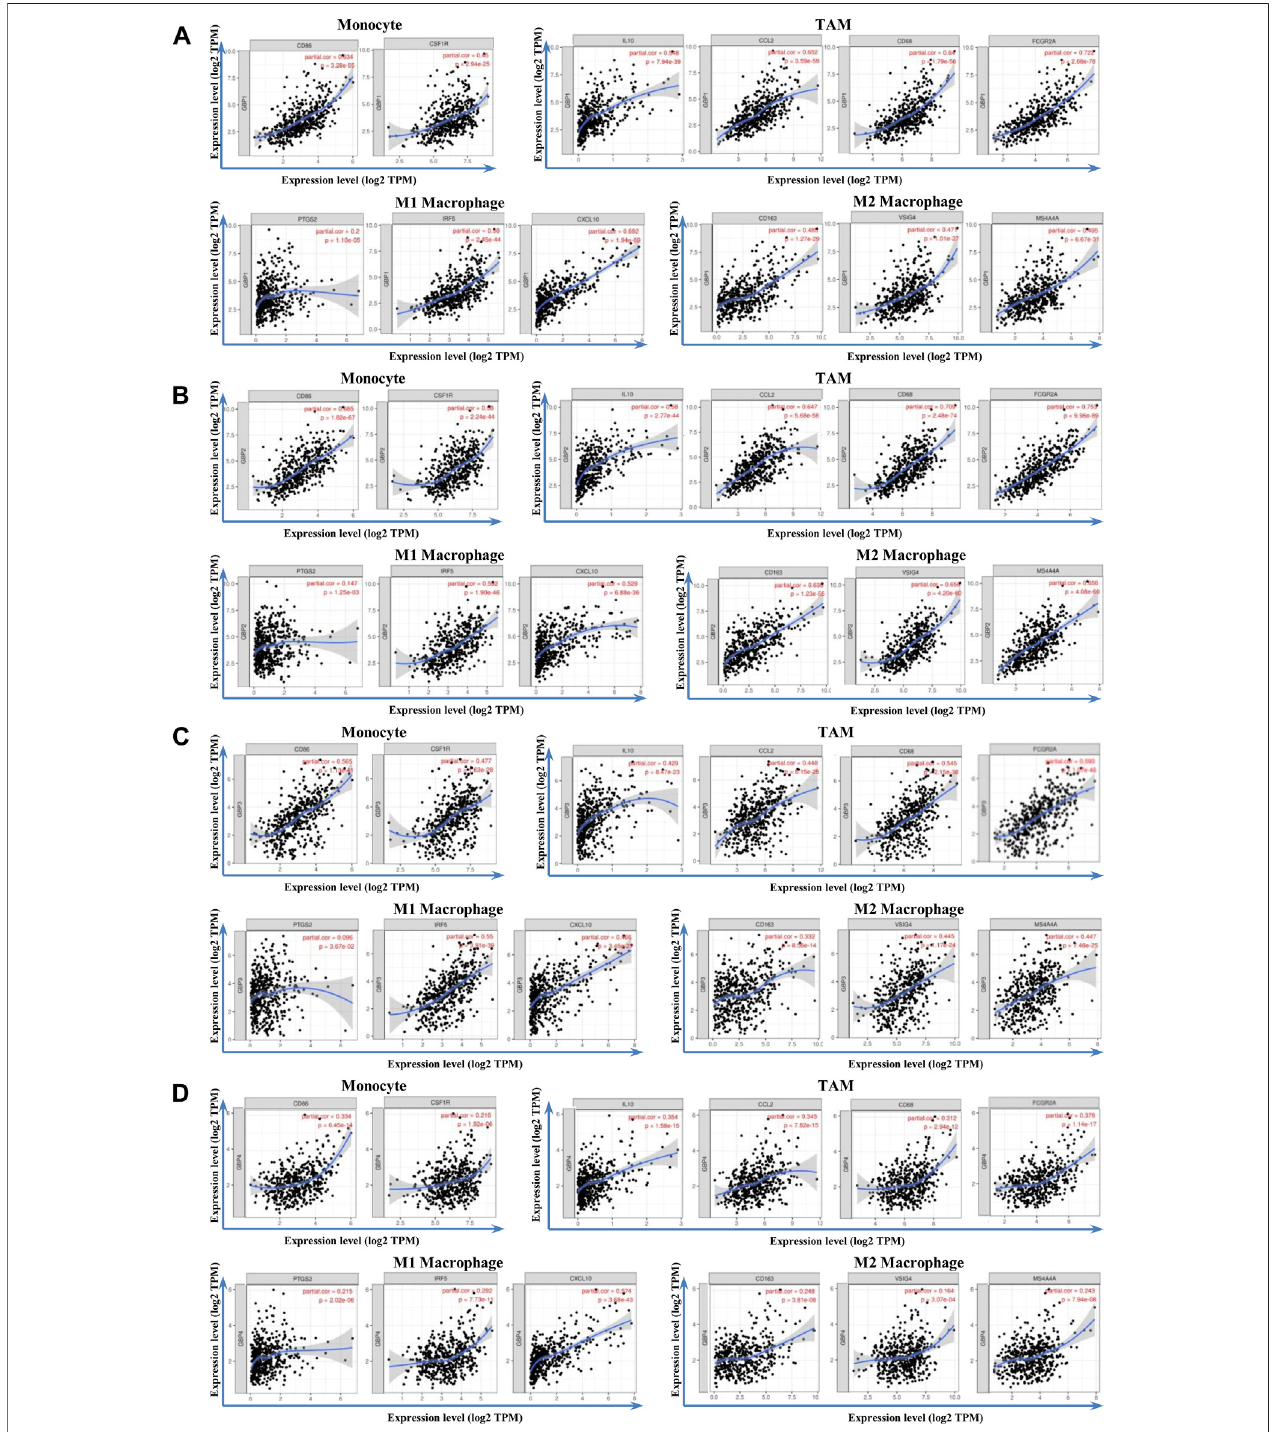
FIGURE 6 | Correlation analysis between GBP1/2/3/4 and immune markers in LGG patients. The correlation between the expression of GBP1/2/3/4 and monocytes(genemarkers:CD86andCD115),TAM(genemarkers:IL10,CCL2,CD68,andFCGR2A),M1macrophage(genemarkers:PTGS2,IRF5,andCCL10),and M2macrophage(genemarkers:CD163,VSIG4,andMS4A4A)in fi ltrationlevelswasassessed.Scatterplotsofcorrelationsbetweenmonocytes,TAM,M1macrophage, M2 macrophage, and the expressions of (A) GBP1 (B) GBP2, (C) GBP3, and (D) GBP4 in LGG